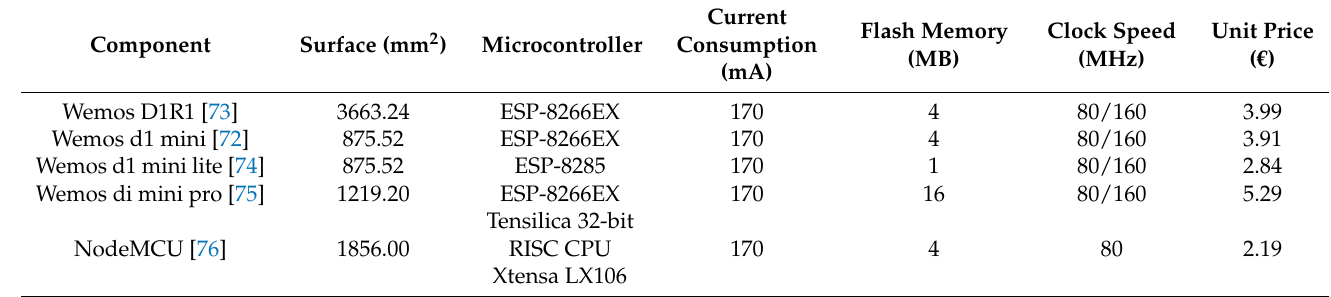
Table 2. Arduino Wi-Fi family